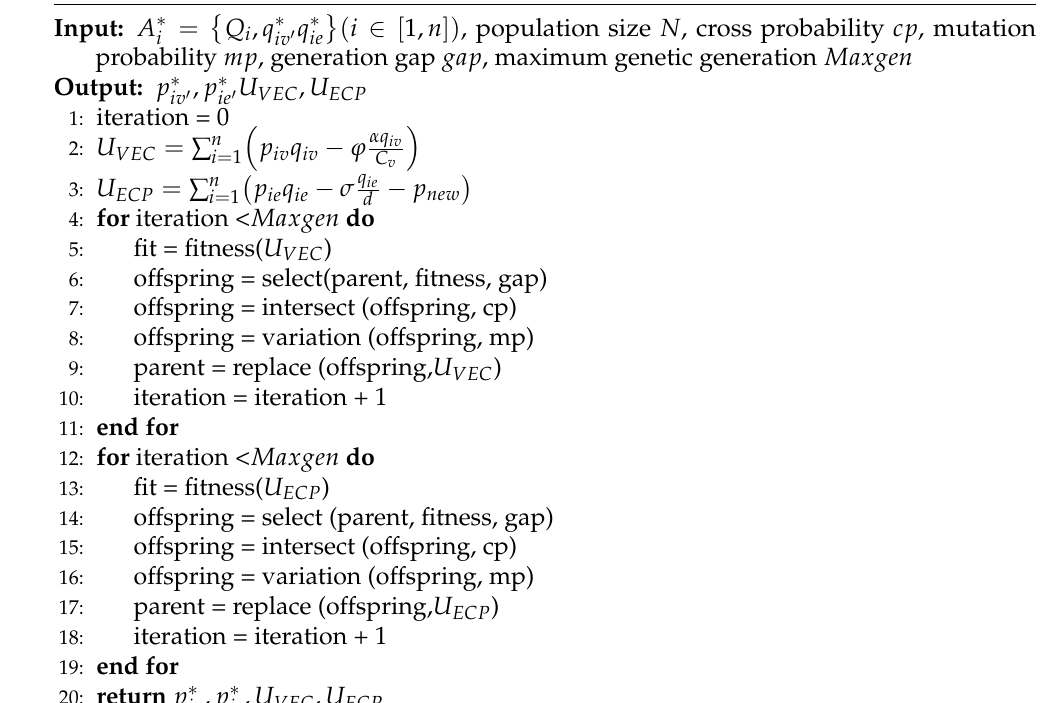
Algorithm 1 GSA (Game Strategy